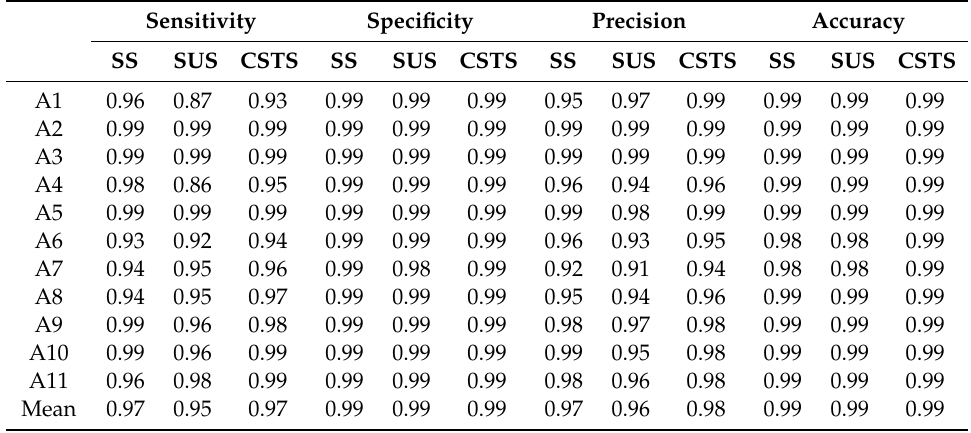
Table 5. Classification performance for each activity (A1–A11) using K-NN models at the group level. Sensitivity Specificity Precision